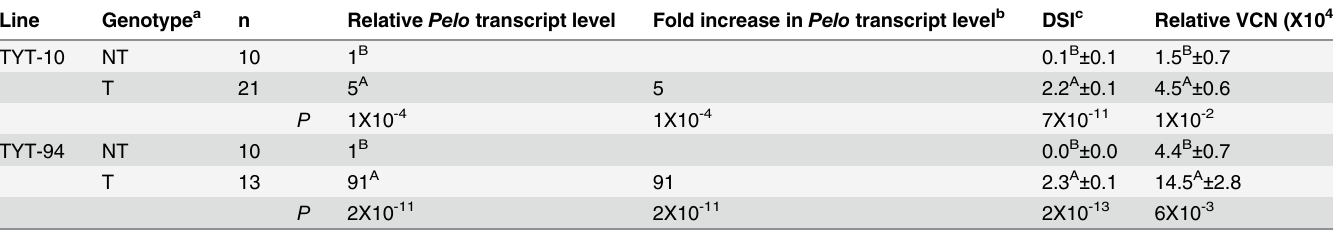
Table 2. Effect of over-expressing the Pelo allele from M-82 plants in transgenic TY172 plants. Line